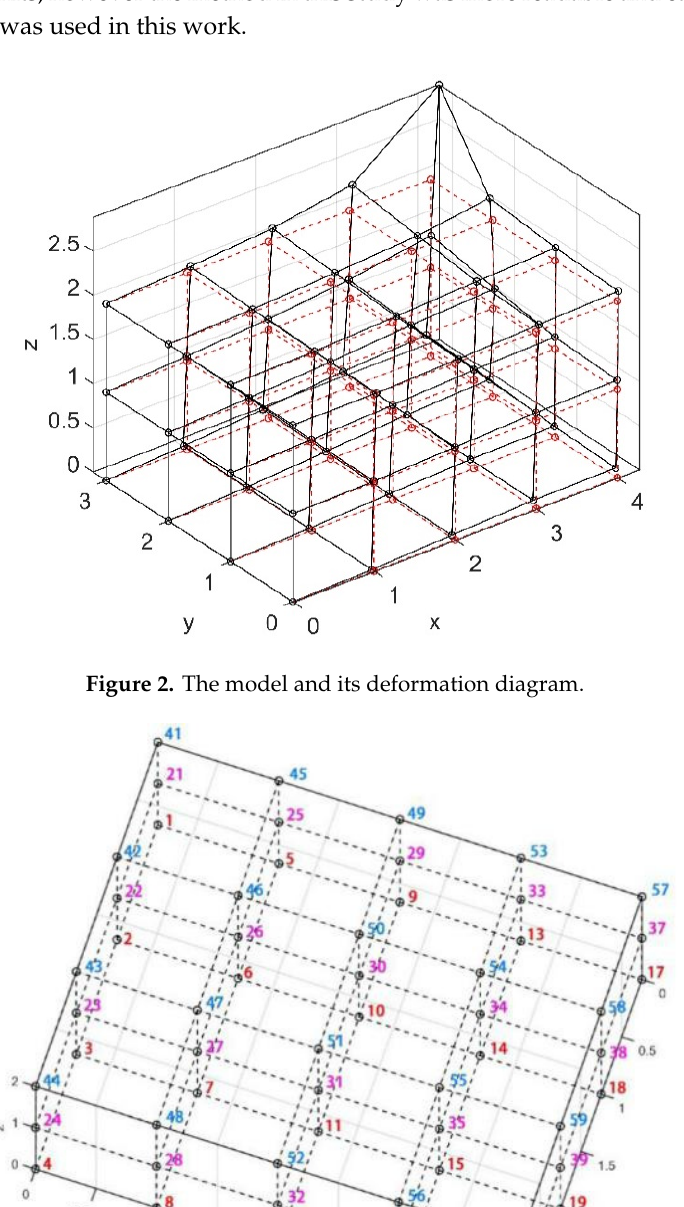
Figure 4. Individual units and their numbers. (4) Global stiffness matrix assembly In this section, the global stiffness matrix was assembled by filling the corresponding element stiffness matrix in the corresponding position. The code representation is shown in Supplementary CODE. 6. 4. Optimizer Based on Optimal Criterion Method The Optimality Criteria method, proposed by Sigmund, (also known as the OC method) is used. Then, the Lagrange multiplier method is used to derive the expression of the OC method as shown in Equation (23). For the sake of simplicity, since the expressions of MSE and SE are similar, MSE is omitted here.